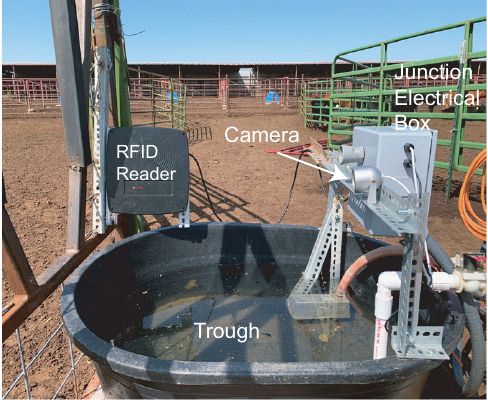
Figure 8. The side view of the drinking station showing the Radio-Frequency Identification (RFID) reader and the motion detector triggered camera.